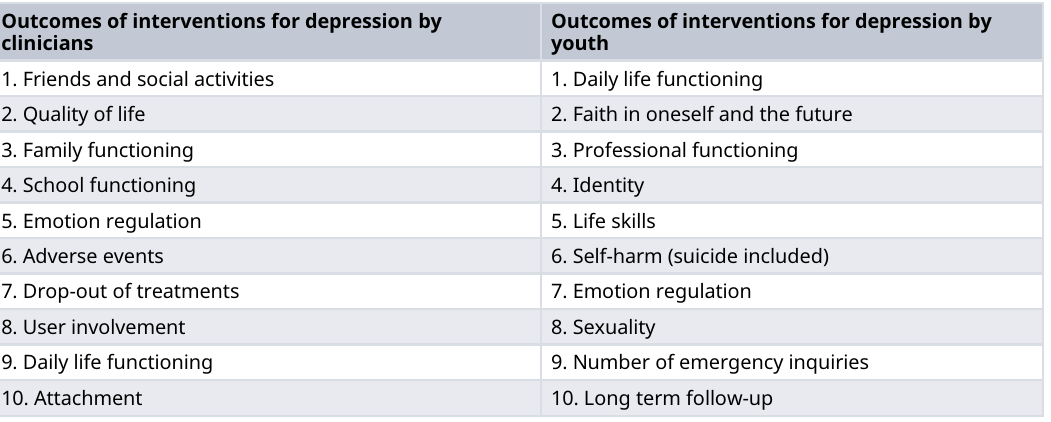
Table 6. Prioritised outcomes of interventions for